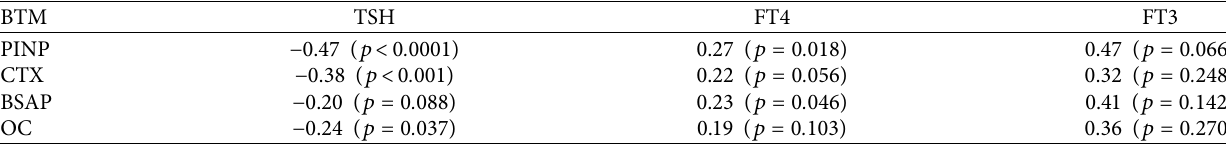
Table 2: Spearman’s rho values for correlations of TSH, FT4, and FT3 on four bone markers: procollagen type 1 N-terminal propeptide (PINP); C-terminal cross-linking telopeptide of type 1 collagen (CTX); bone specific alkaline phosphatase (BSAP), and osteocalcin